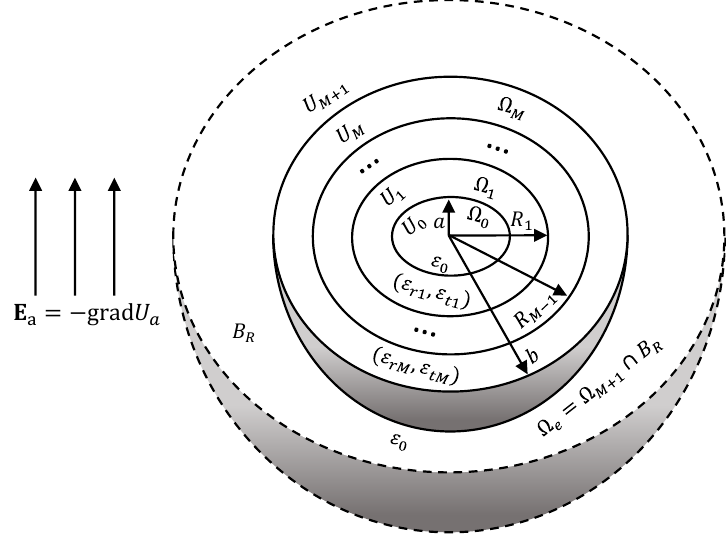
Figure 2. Schematic representation of a ball B R containing the multilayer spherical shell ( Ω , ε )